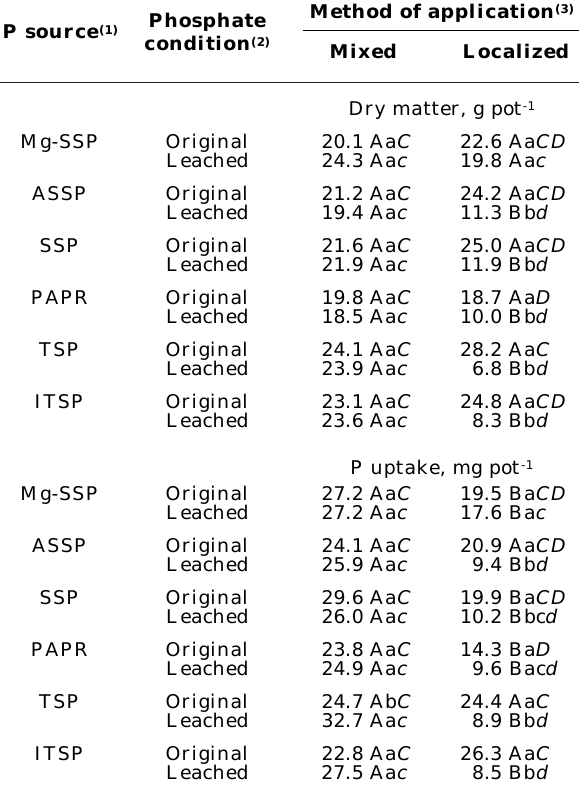
Table 3. Effect of method of application, water leaching and acidulated P fertilizers on the yield of dry matter and P uptake by corn plants grown for 40 days in samples of a Red-Yellow Latosol (first